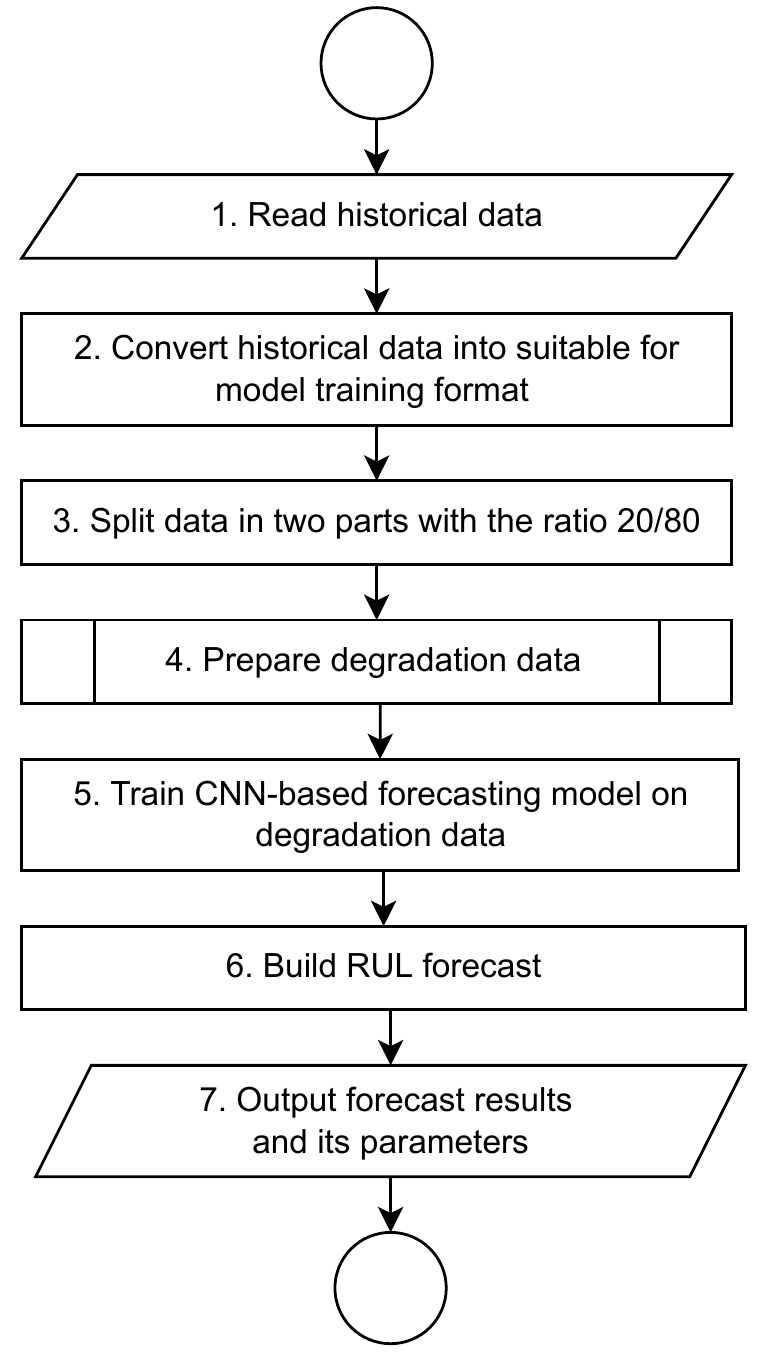
Figure 12. Proposed RUL forecasting method with